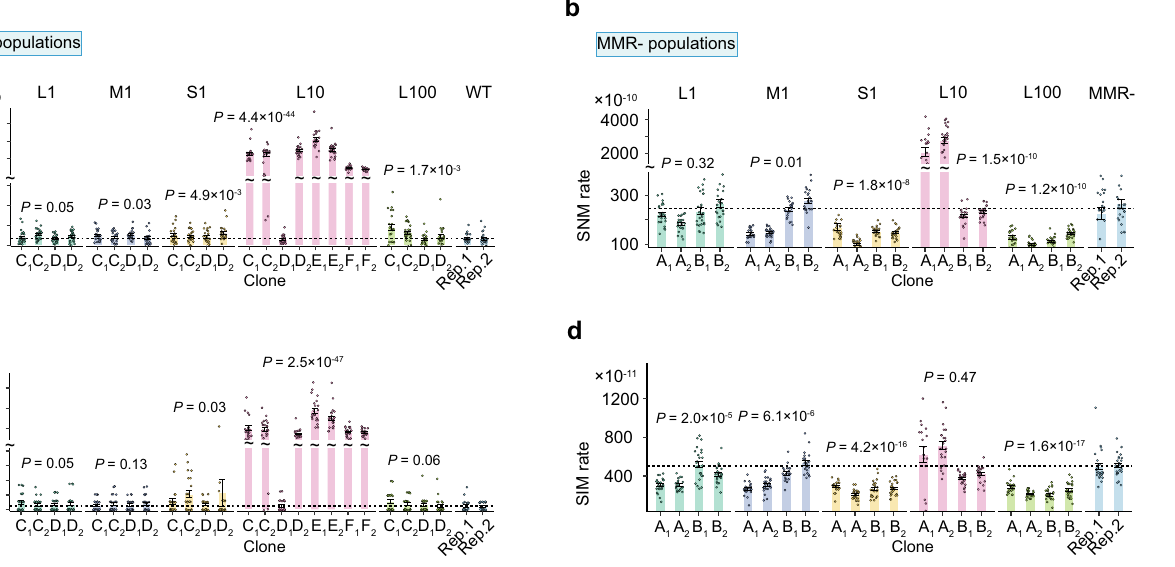
25, 22, 24, 25 and 24 (S1-A1, A2, B1, B2, C1, C2, D1, and D2, respectively); n =18, 24, 24, 24, 19, 24, 24, 23, 23,24, 22,and 24 (L10-A1, A2, B1, B2, C1, C2, D1, D2, E1, E2, F1, andF2,respectively); n =24,23,26,25,22,25,23,and23(L100-A1,A2,B1,B2,C1,C2, D1, and D2, respectively); n =21 and 23 (WT); n =24 and 24 (MMR-). Data are pre- sented asmean values +/ − the standard errorsof the means (S.E.M.); P -values were acquired by two-tailed unpaired t -tests contrasting MA lines from evolved popu- lations and MA lines from the ancestor. Dashed lines represent absence of sig- ni fi cant difference of mutation rates compared to the ancestral mutation